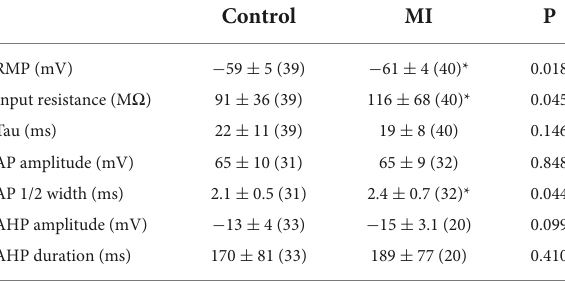
TABLE 1 Active and passive membrane properties of porcine IVC-ILA ICNs (mean ±